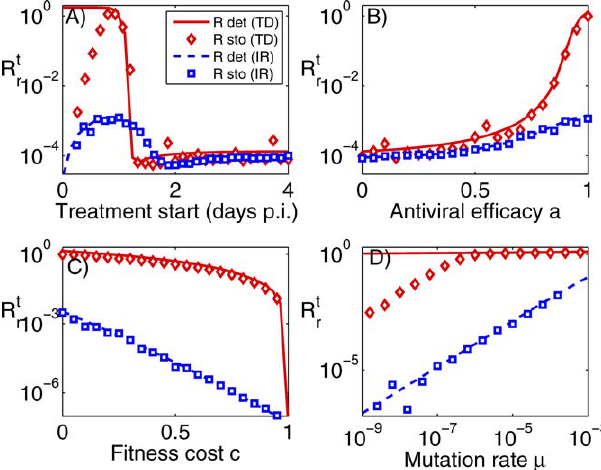
Figure 4. Generation of Resistance, as Measured by R t (No Immune Response) and IR Model (with Immune Response) Results are shown for both deterministic and stochastic simulations. Unless varied, treatment starts 24 h post-infection, and the other parameters are as shown in Table 2.